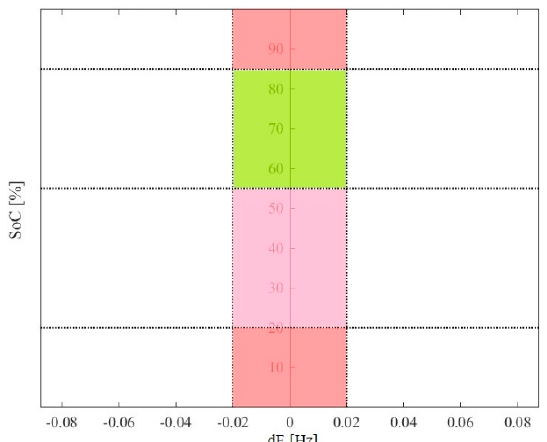
Figure 8. The double threshold domain for SoC restoration. The red area identifies the condition of (dF, SoC) for triggering the flag variable and starting SoC restoration. The pink area is where the offsetting can be exploited for charging towards SoC target . The green area shows where P req can offset to discharge.